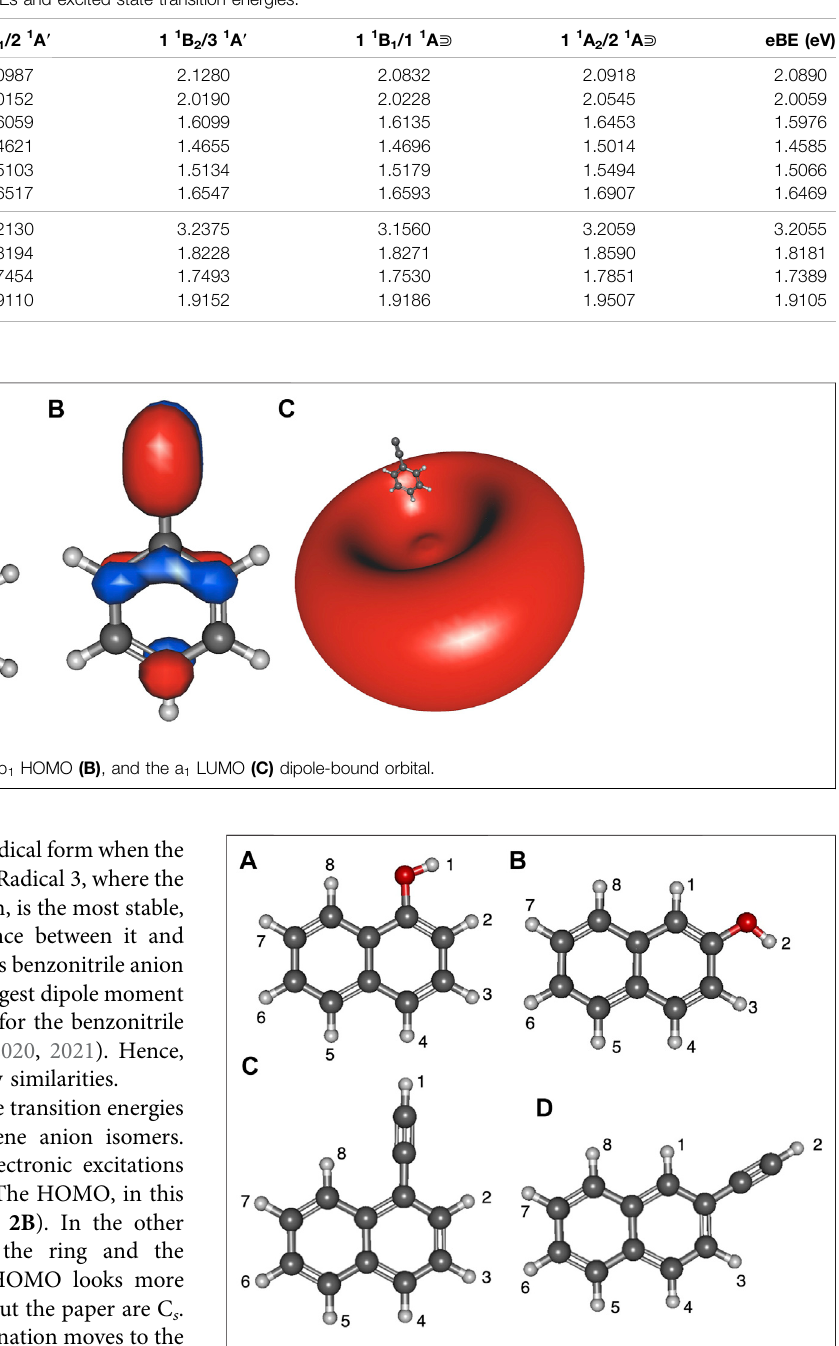
FIGURE 3 | Optimized structures of the four naphthalene derivatives with numbered positions of deprotonation: (A) 1-hydroxynaph, (B) 2- hydroxynaph, (C) 1-ethynylnaph, (D)